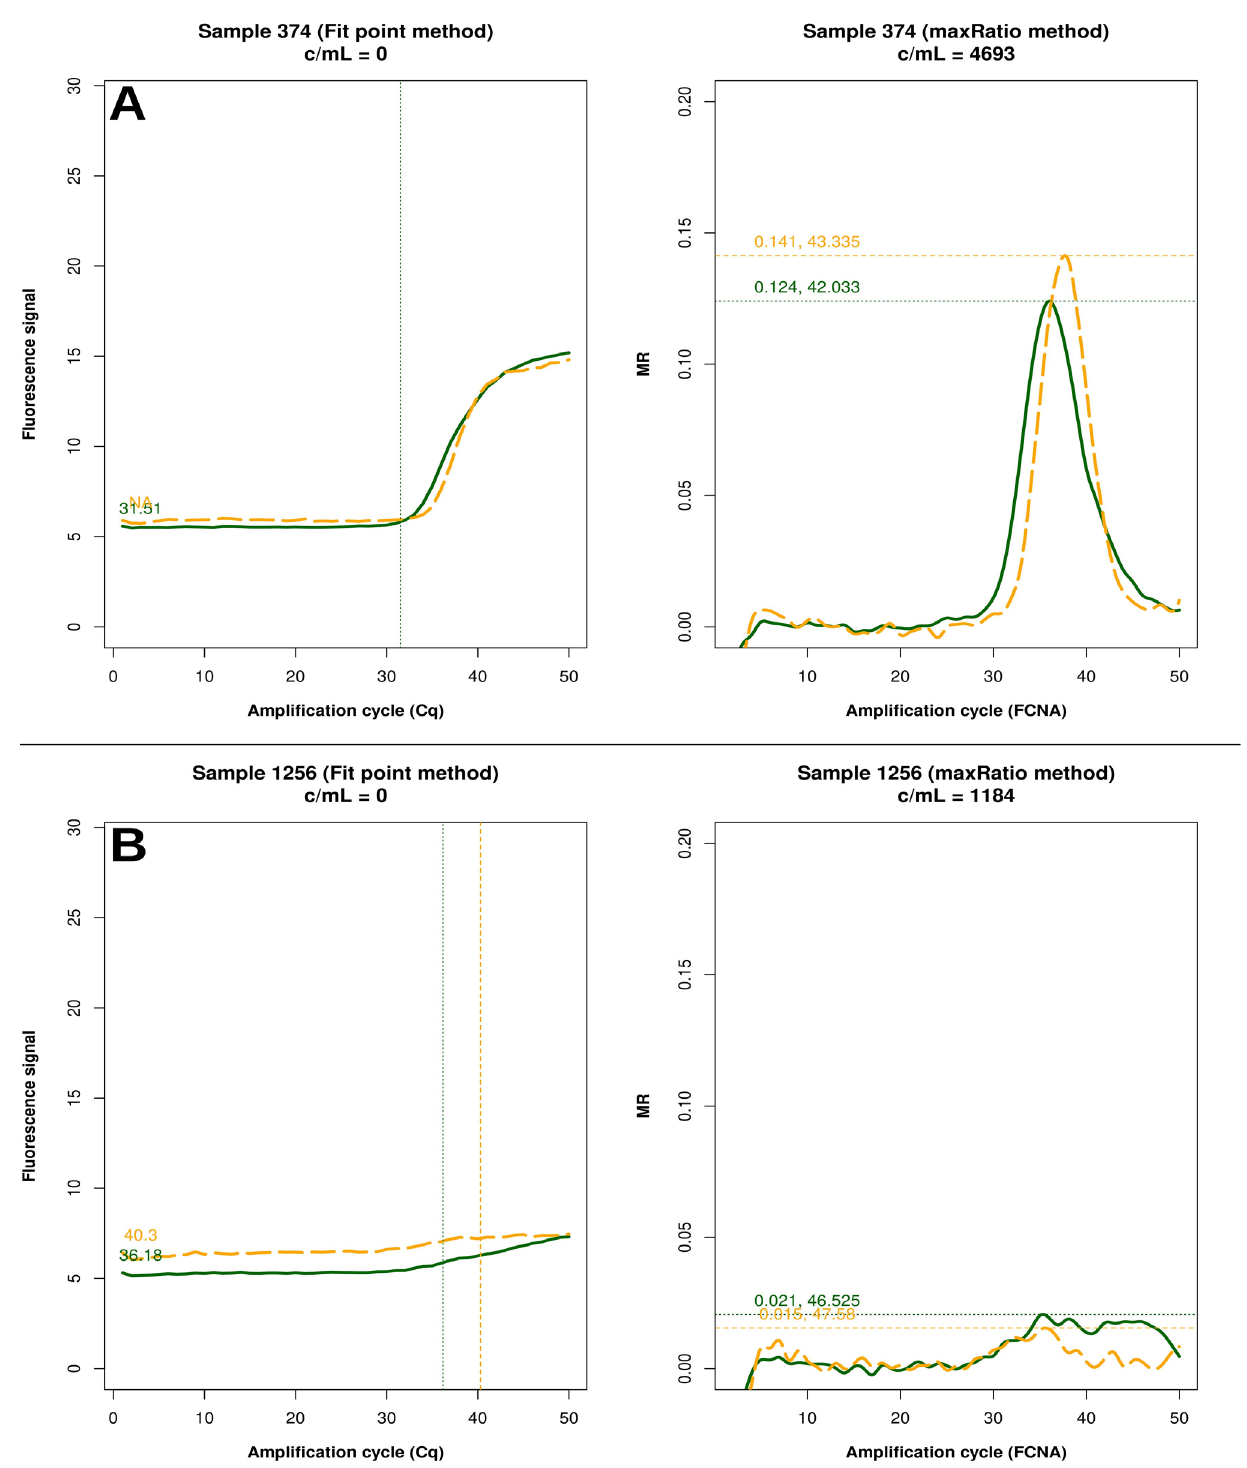
Figure 5. Samples not quantified only by FP. Example of raw amplification profiles for the samples whose FP did not provide a VL. The panels display the FP (left) the maxRatio (right) transforms of the amplification data. The solid line represents the HIV-1 template and the dashed line the IC template. ( A ) The majority of the samples had a proper IC profile but the output was undetermined. ( B ) The minority of the samples showed low target